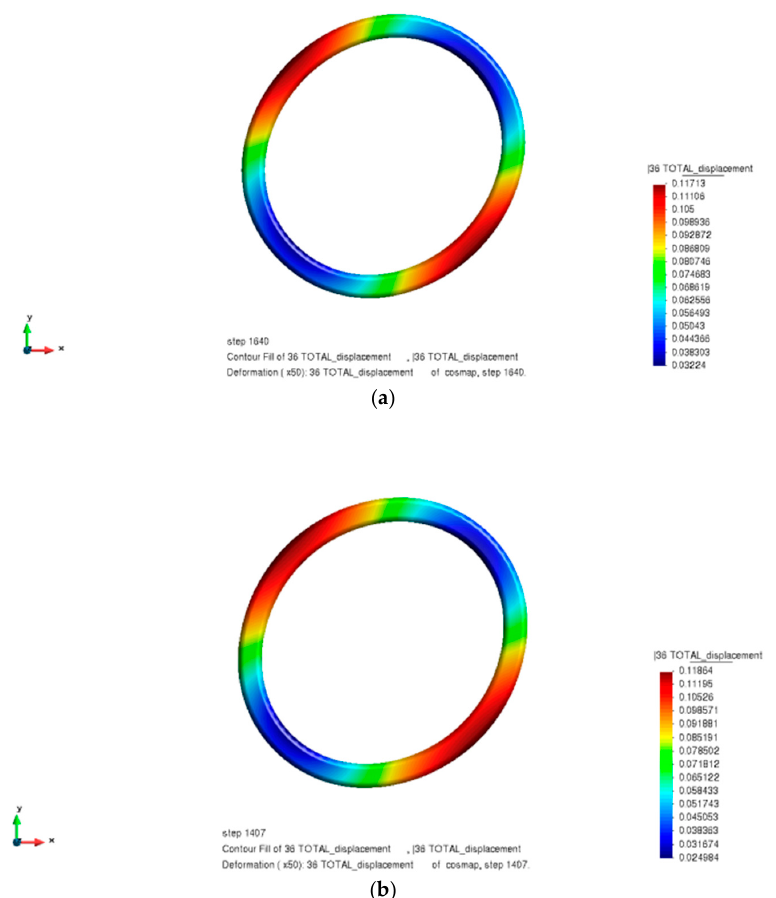
Figure 14. Deformation (×50) by orthogonal symmetric heat transfer and orthogonal symmetric heat transfer on the outer surface, axial symmetry heat transfer on the inner surface. ( a ) Deformation (×50) by orthogonal symmetry heat transfer ; ( b ) deformation(×50) by orthogonal symmetric heat transfer on the outer surface and axial symmetry heat transfer on the inner surface.